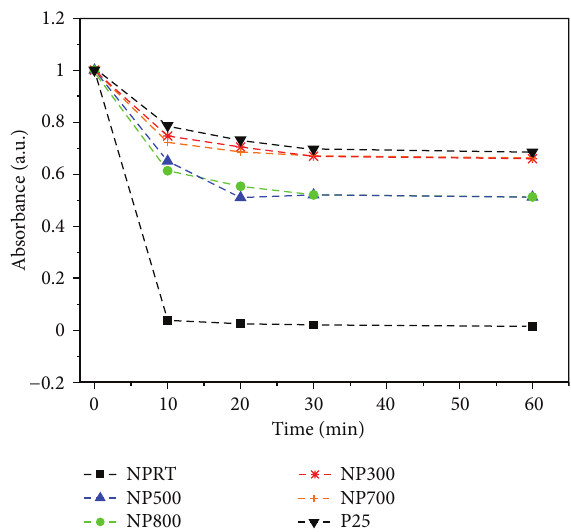
Figure 4: Photodegradation of MB (10 −5 M, pH 7.2) solution as a function of UV-A irradiation time for TiO 2 powders annealed at different temperatures and reference P25. Table 1: Rate constant ( 𝑘 ) and degradation (%) of the MB (10 − 5 M, powders annealed at different pH 7.2) solution for TiO 2